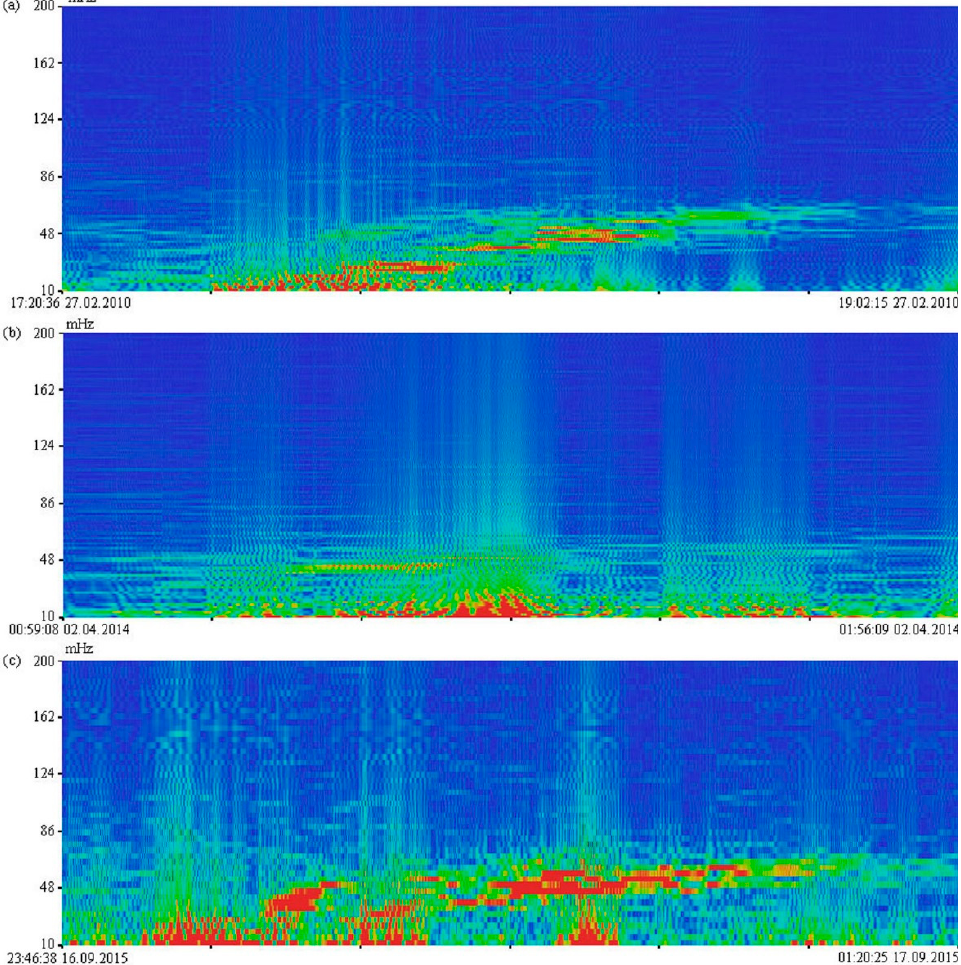
Figure 6. Dynamic spectrograms of 52.5 m laser strainmeter recordings from February 2010 ( a ), April 2014 ( b ), and September 2015 ( c ).